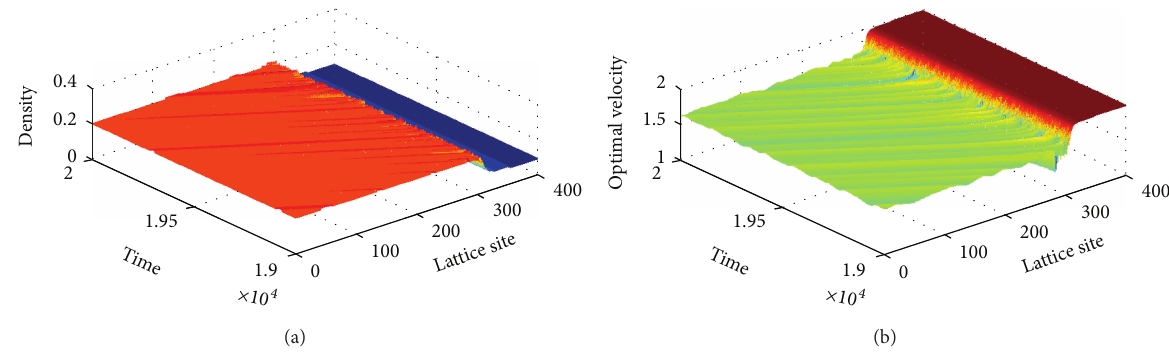
Figure 8: The spatiotemporal evolutions of HST for 𝜌 ℎ = 0.09 , 𝑄 on = 0.09 .